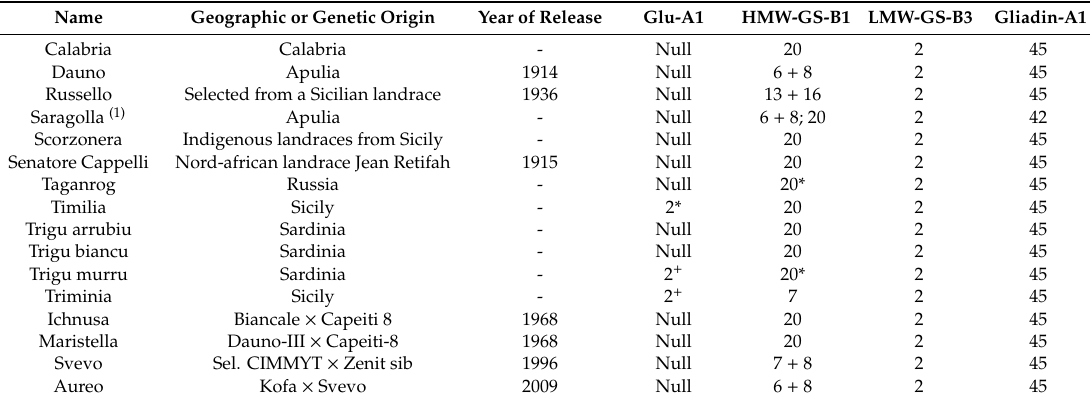
Table 1. The investigated genotypes, their relative year of release, geographic or genetic origin, and details of the allelic composition of gluten